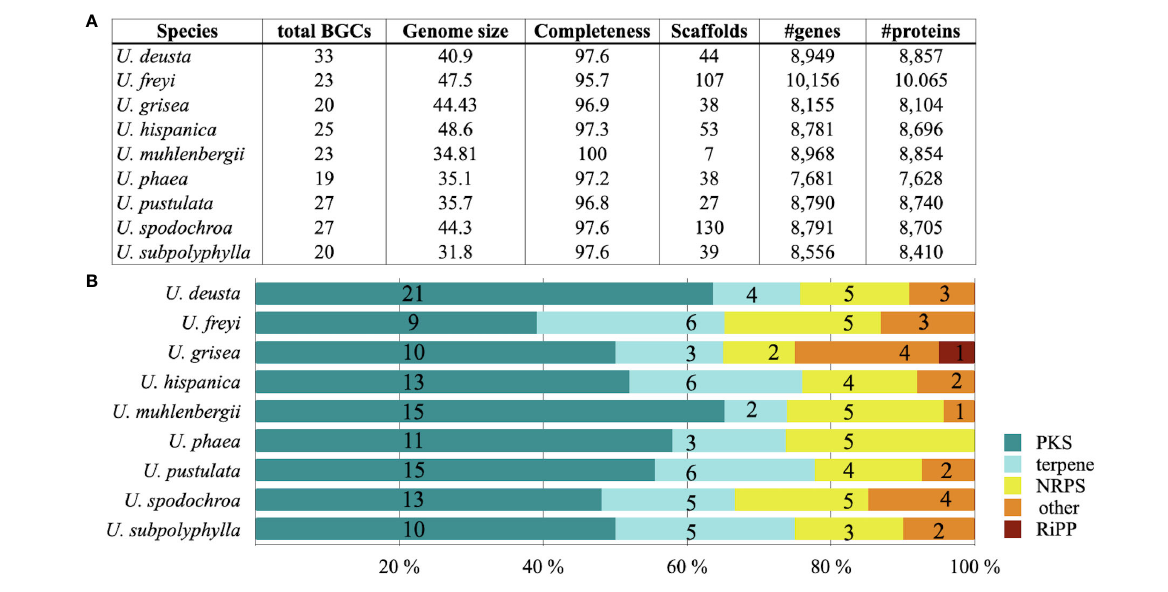
FIGURE 1 Genome quality metrics and diversity of biosynthetic genes in nine species of Umbilicaria . (A) Genome metrics, including the total number of biosynthetic gene clusters (BGCs) as predicted by antiSMASH, and the number of genes and proteins estimated by InterProScan and SignalP, as implemented in the Funannotate pipeline. (B) Diversity of BGCs associated with major natural product categories, indicated as percentages (colored bars) and absolute numbers (numbers on